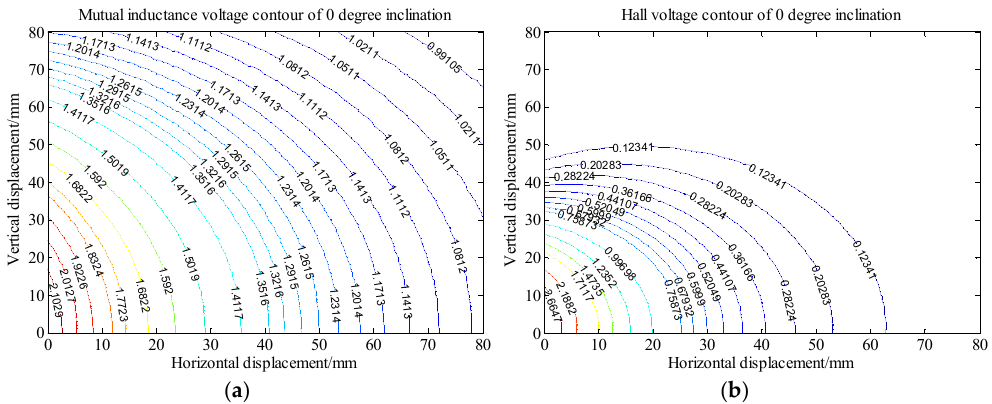
Figure 11. Voltage contour at 0 o inclination. ( a ) Mutual inductance voltage contour; ( b ) Hall voltage contour.